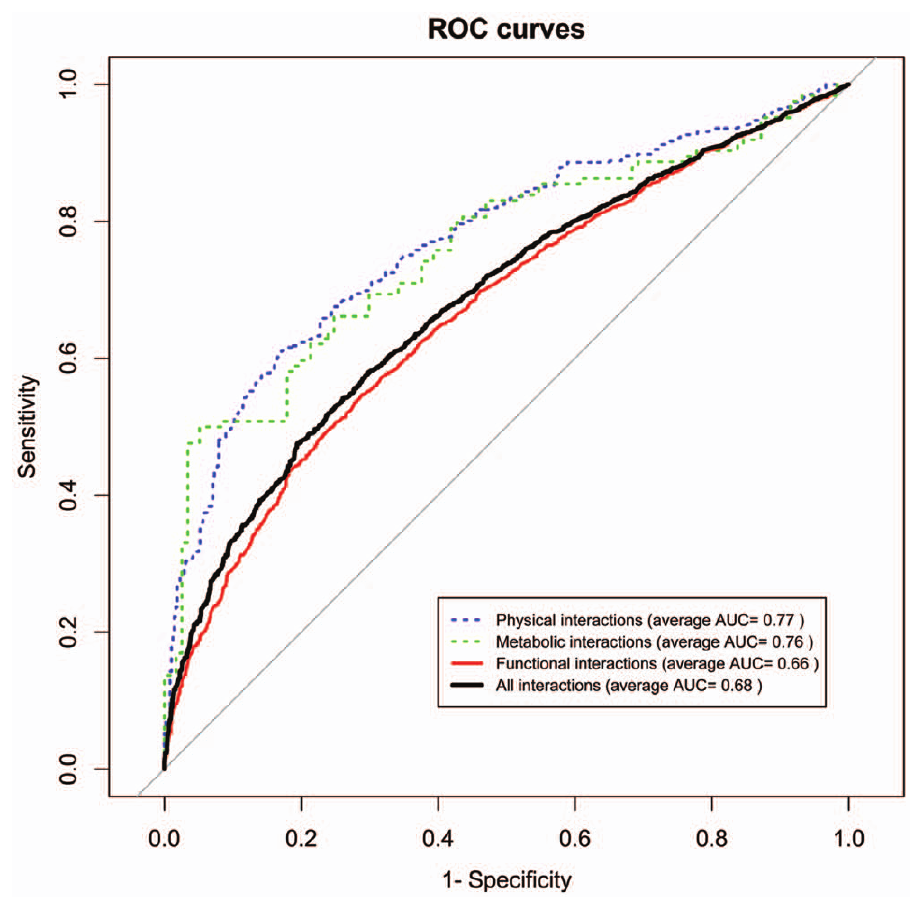
Figure 7. Receiver operative characteristic (ROC) curve performance by biomolecular interactions of pathophenotypic similarities. Physical interactions (dashed blue line), metabolic flux correlations (dashed green line), functional interactions (red continuous line) and an integrated interactome generated by the sum of all other interactomes (black continuous line). ROC curves were computed to assess the signal of pathophenotypic similarities for biological interactions. True positives (TP) were those interactions that where found in the intersection between PSGN and each biomolecular interactome (PIN, MGN and FSGN). The dataset of false positives (FP) was calculated from intersected gene pairs between PSGN and randomizations of each biomolecular interactome. We obtained severals different FP datasets to calculate the average area under the curve (AUC), it was 0.77 for PIN, 0.76 for MGN, 0.66 for FSGN and 0.68 for the integrated interactome. Only biochemical interactomes show significantly different AUCs to that of the integrated interactome (average p-values of 2.2E 2 6 and 4.1E 2 2 for PIN and MGN